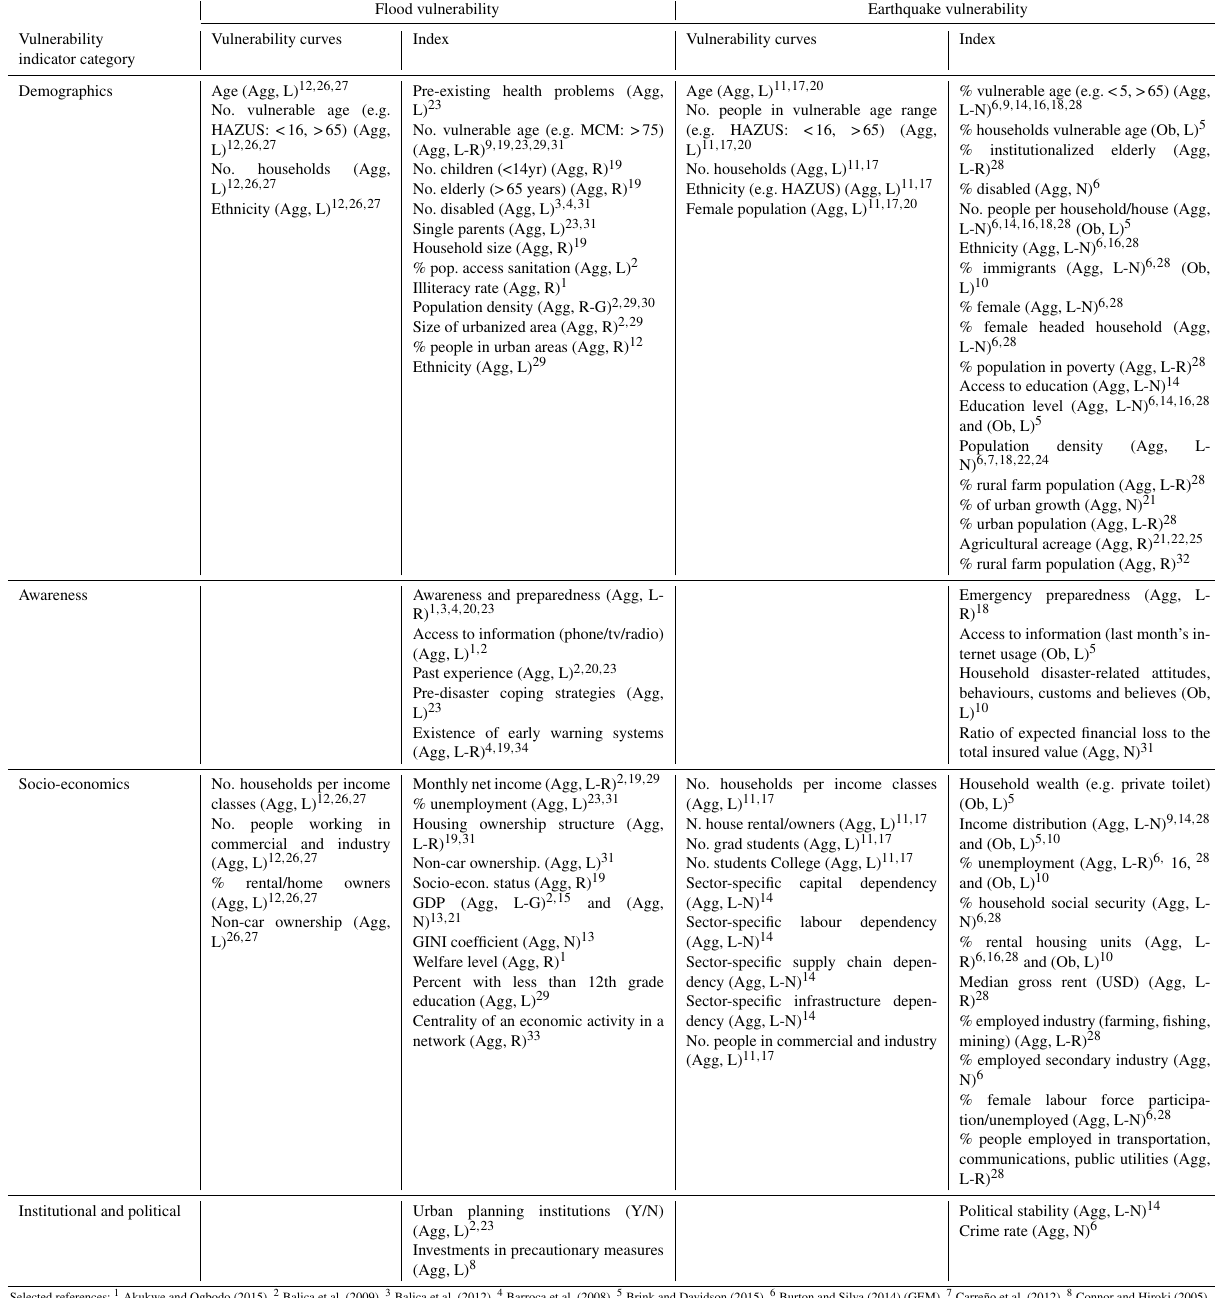
Table 2. Overview of social earthquake and flood vulnerability assessment